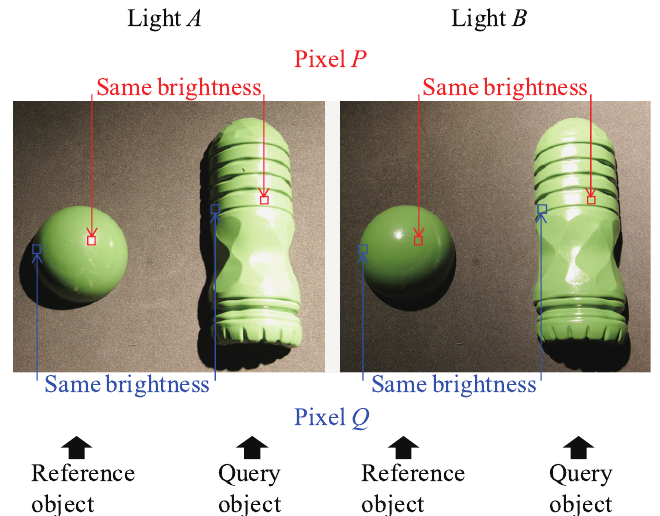
Figure 2. Brightness search of the example-based photometric stereo.